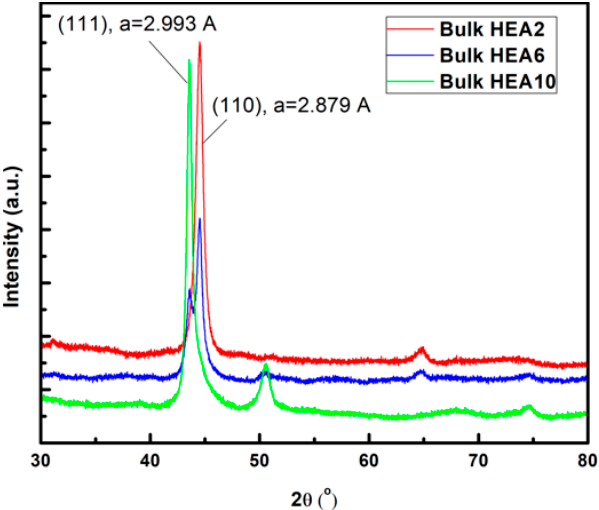
Figure 1. XRD patterns show a structural evolution of HEAs bulk SS targets from bcc (red line) to a mixed bcc-fcc structure (blue line) and finally fcc (green line) due to an increase of nickel molar content.